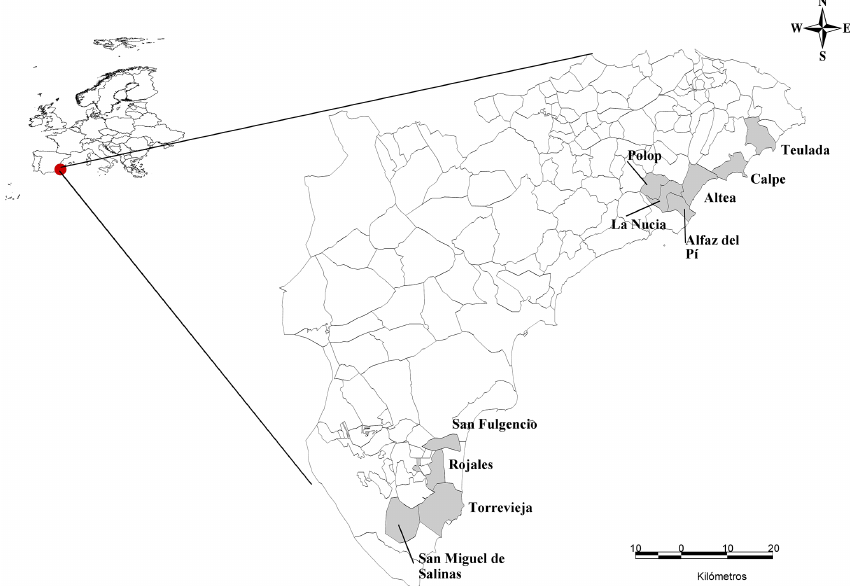
Figure 1. Study area.